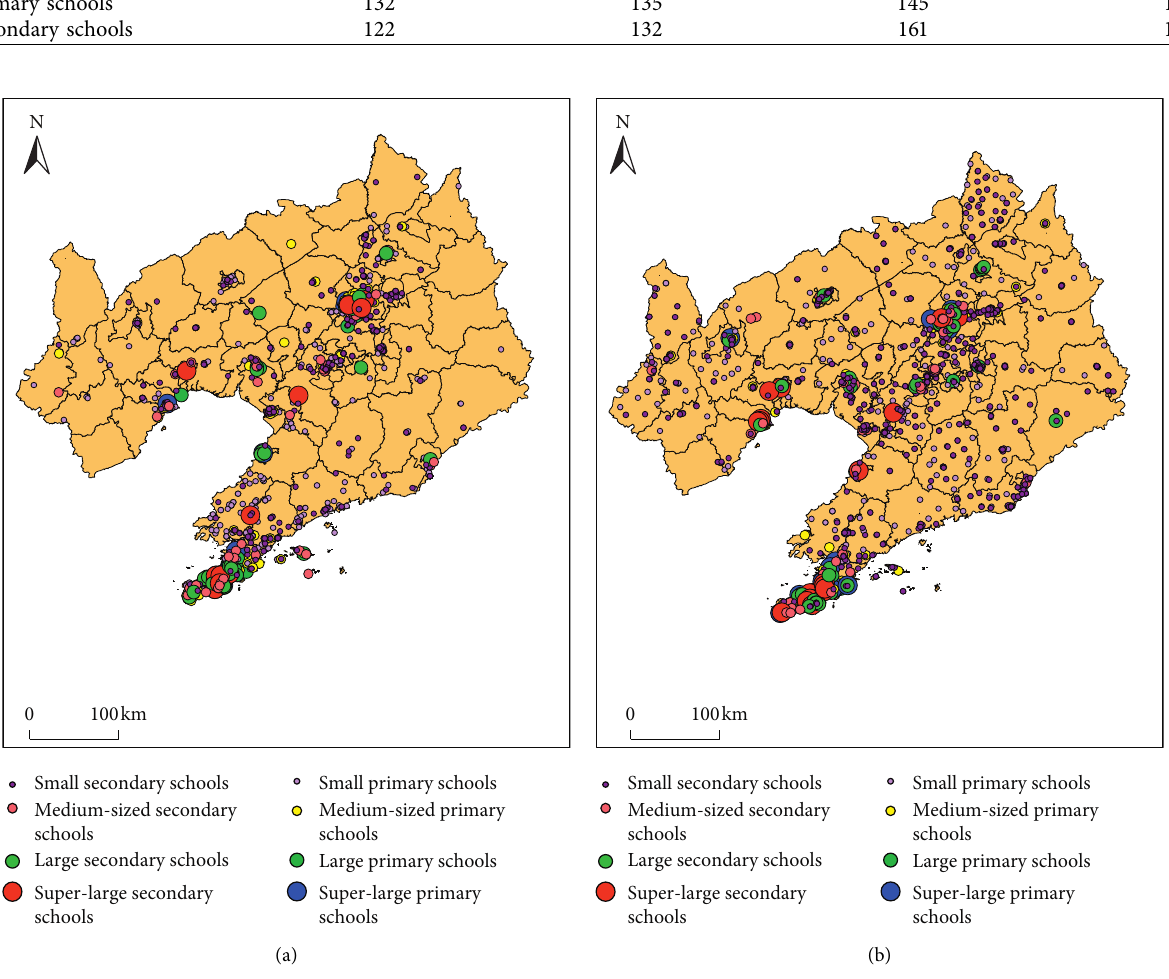
Figure 9: The spatial distribution of “small school” and “large school” in Liaoning Province in (a) 2008 and (b)